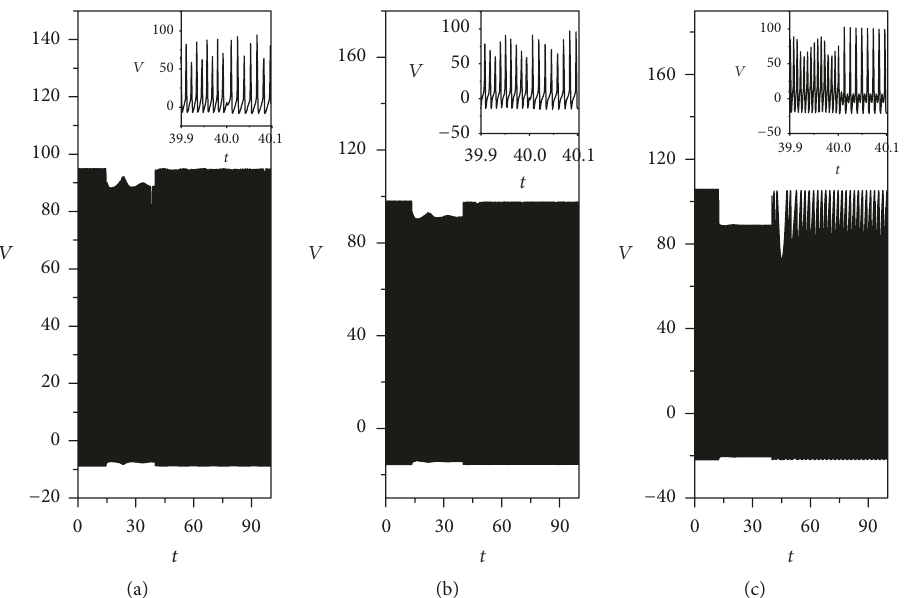
𝜇 mol/L ⋅ cm 2 at 𝑡 < 40 s. ext = 10.0